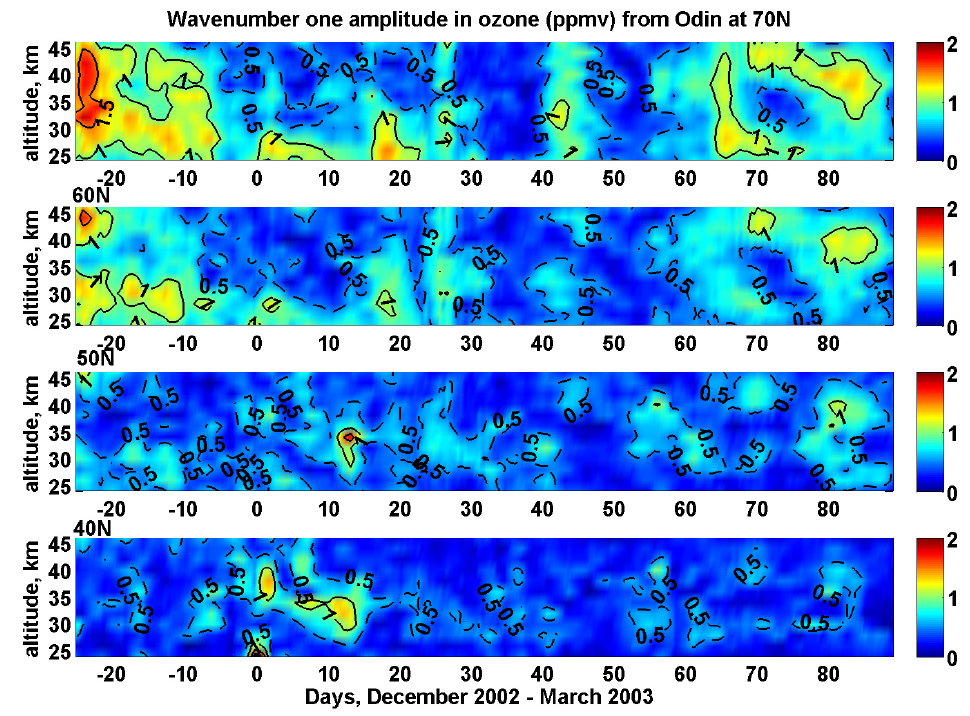
Fig. 5. Wavenumber one amplitude in ozone from Odin SMR data (ppmv) at 70 ◦ N, 60 ◦ N, 50 ◦ N, 40 ◦